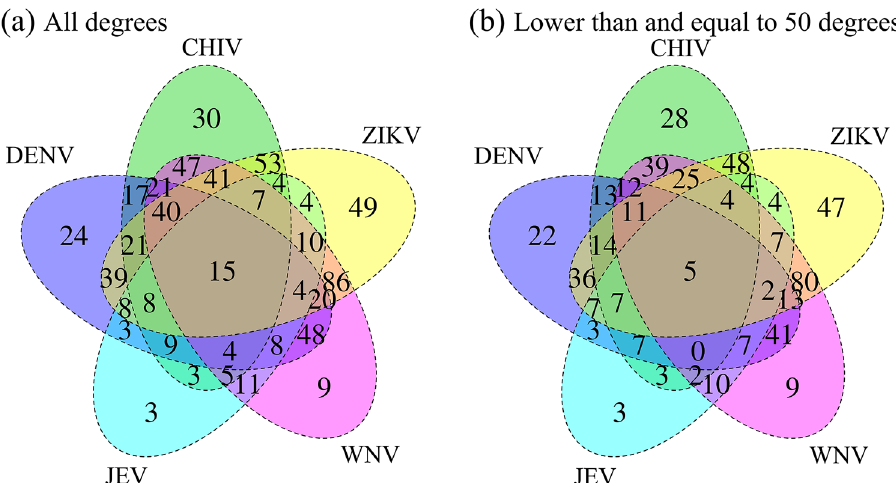
Figure 6. Venn diagrams show the shared numbers of the common and extended signature proteins for the five viral infections. Common and extended signature protein numbers with all degrees are shown in ( a ) and those proteins with lower than and equal to 50 degrees are given in ( b ).